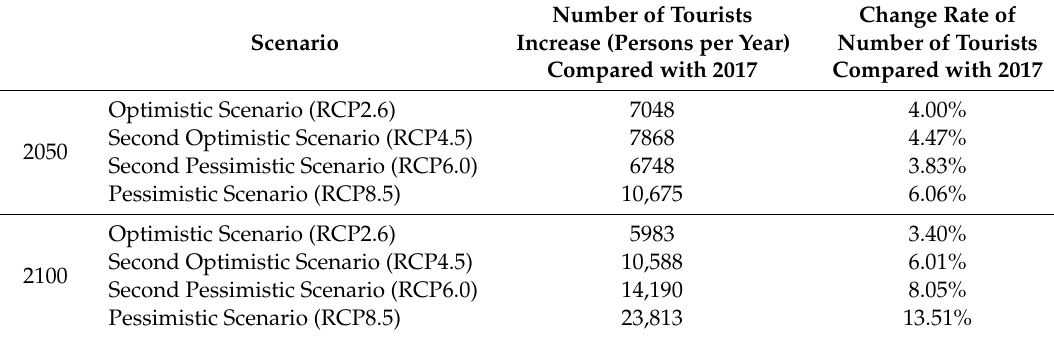
Change Rate of Number of